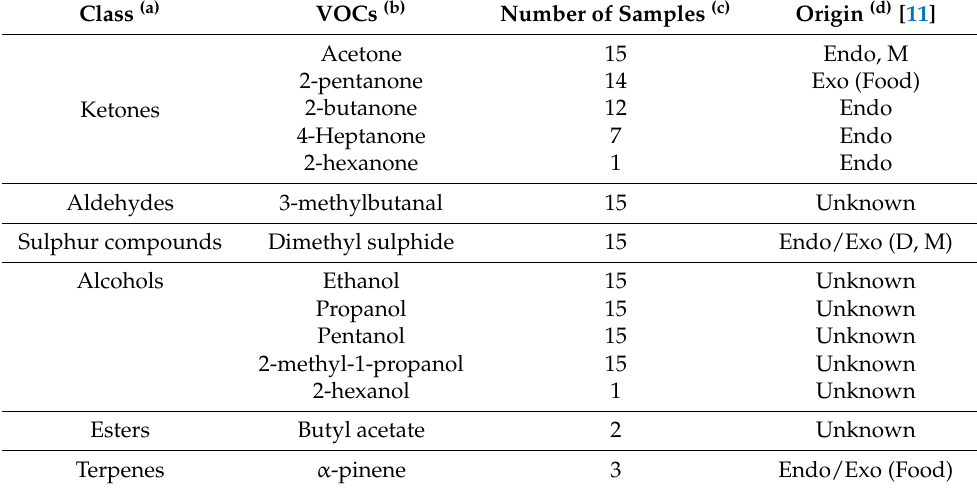
Table 4. Summary of VOCs detected in urine with excess of ketone bodies. (a) class of molecule to which the VOC belongs; (b) list of detected VOCs; (c) number of samples that contain the VOC; (d) putative origin of the detected VOCs (Endo = VOC endogenously produced; Exo = VOC resulting from exogenous sources (food, environment, an medication); M = VOC from microbial metabolism; D = VOC from drug metabolism, as reported by Porto-Figueira et al. [11]). Class (a) VOCs